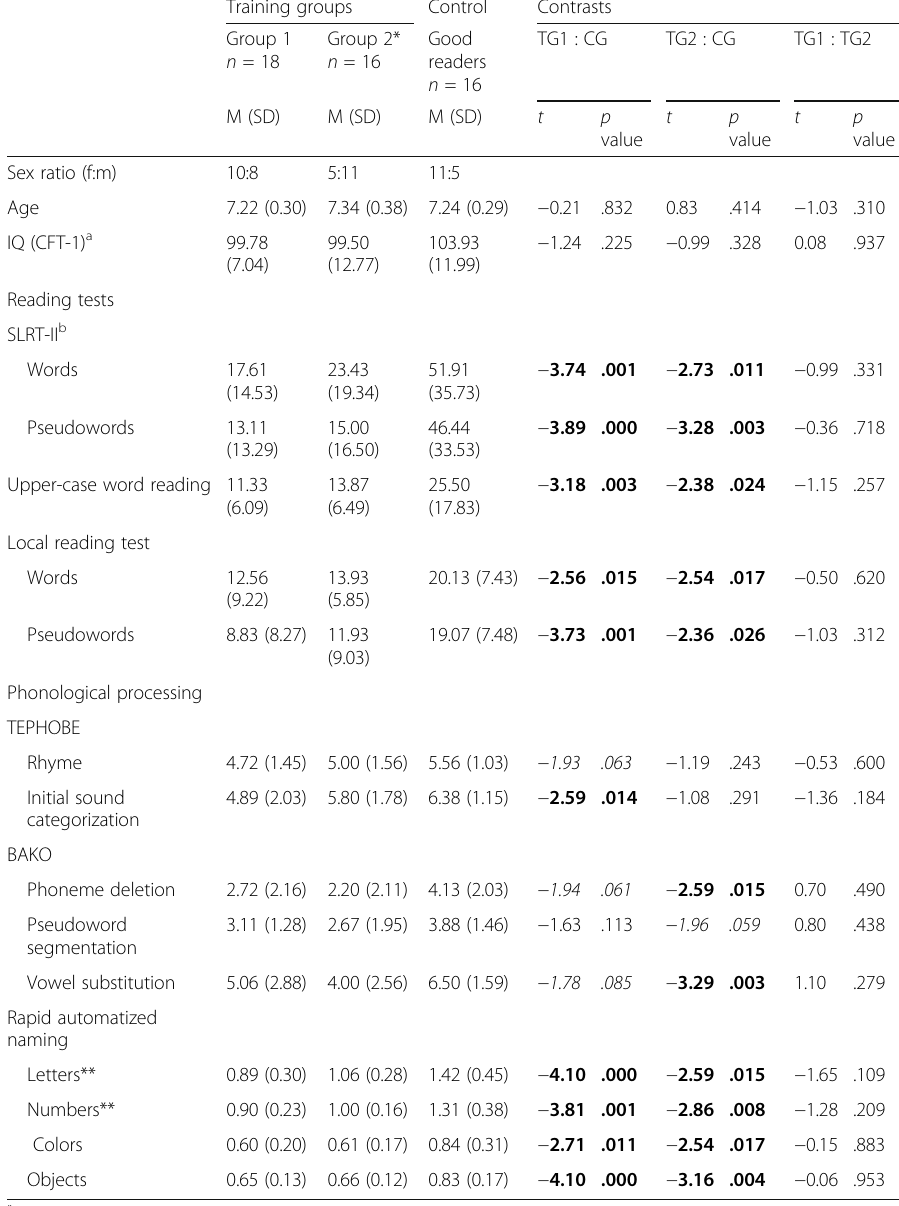
Table 1 Sample characteristics and baseline comparisons at T1 (middle of grade 1) Training